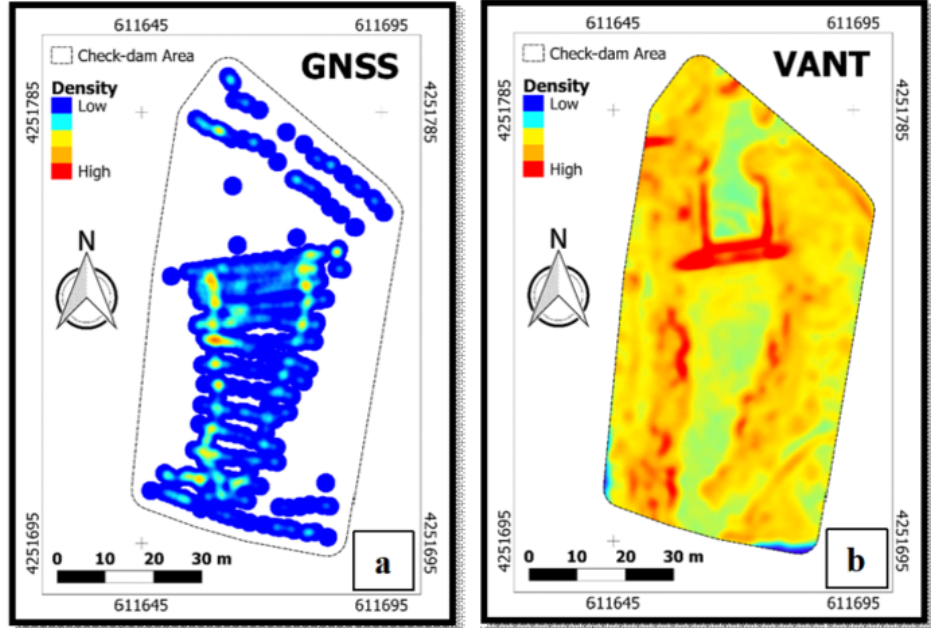
Figure 7. Point clouds obtained by the topographic ( a ) and aerophotogrammetric ( b ) methods for the Palomar check dam (Sierra de Los Donceles forest, Castilla La Mancha, Spain).